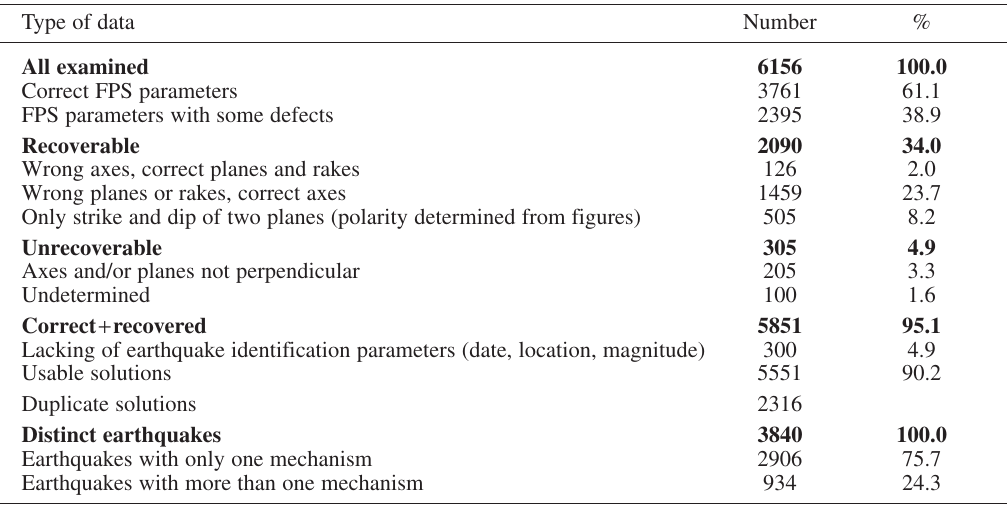
Table I. Summary of the results of the checks performed on the focal mechanisms found in hard copy